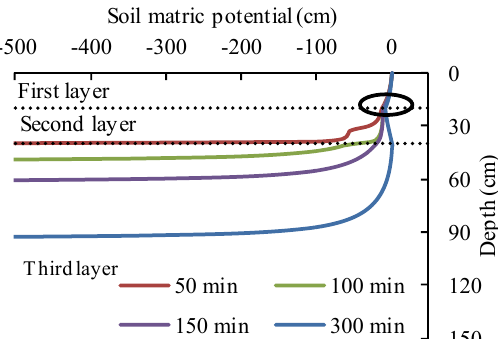
Figure 4. The simulated soil matrix potential profiles for L1S1L1 at different infiltration times.